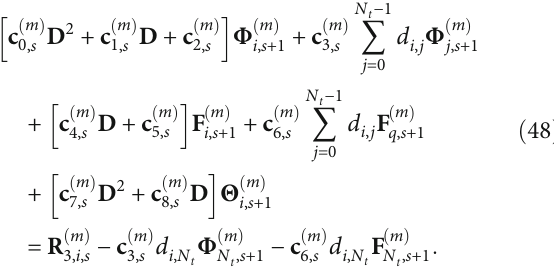
: 8, ξ = 1, N N Df = Sr = Bi = 0 : 5, He b = t = w = 0